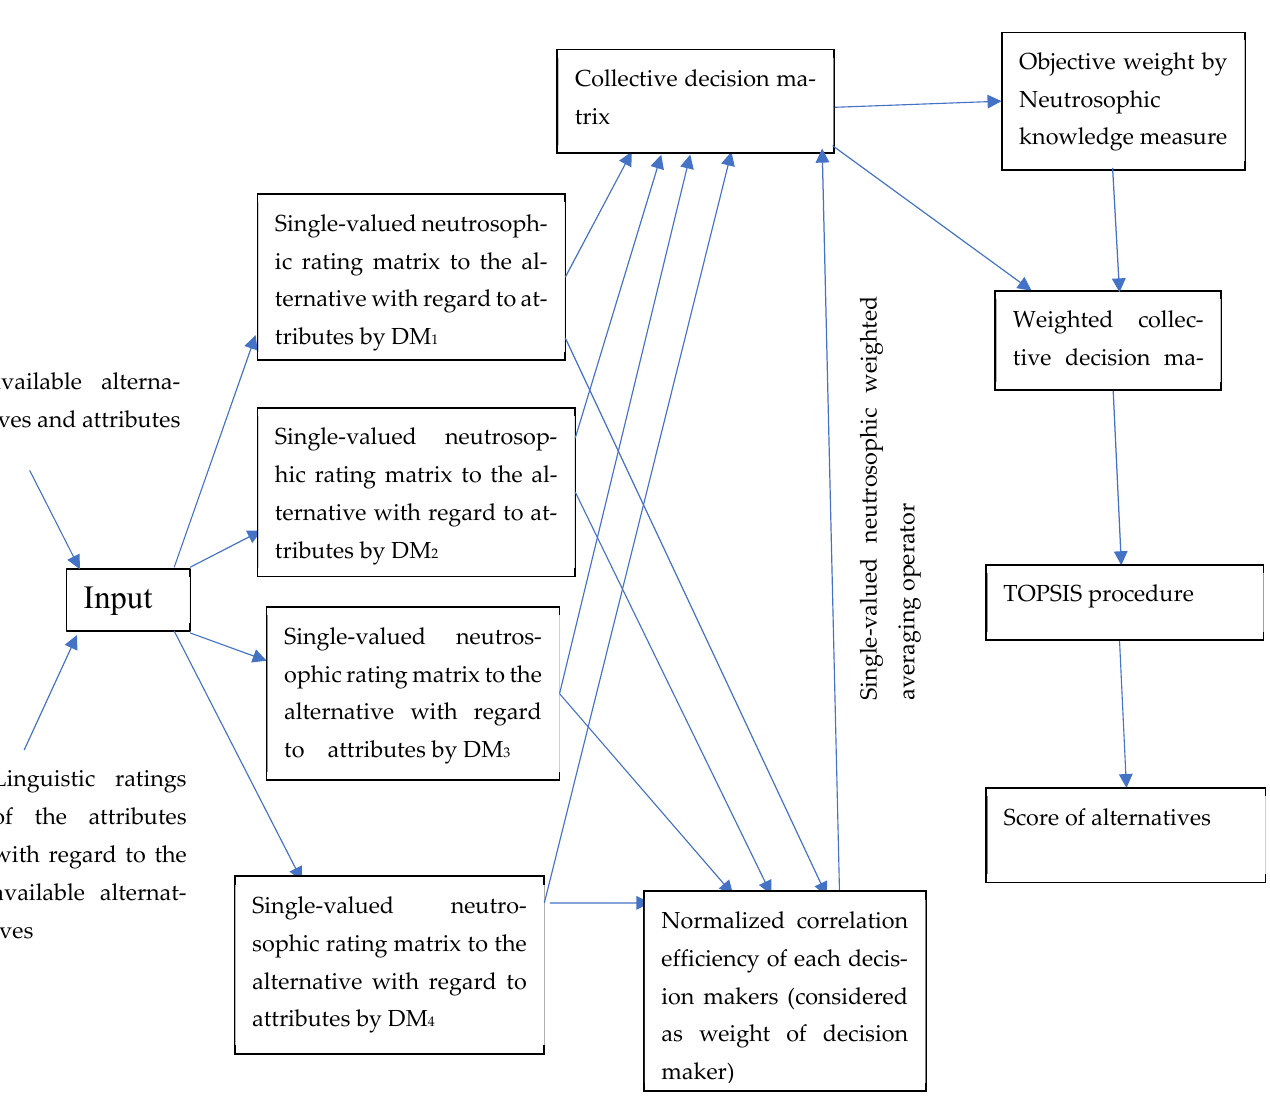
Figure 1. Flowchart for algorithm following in the MADM